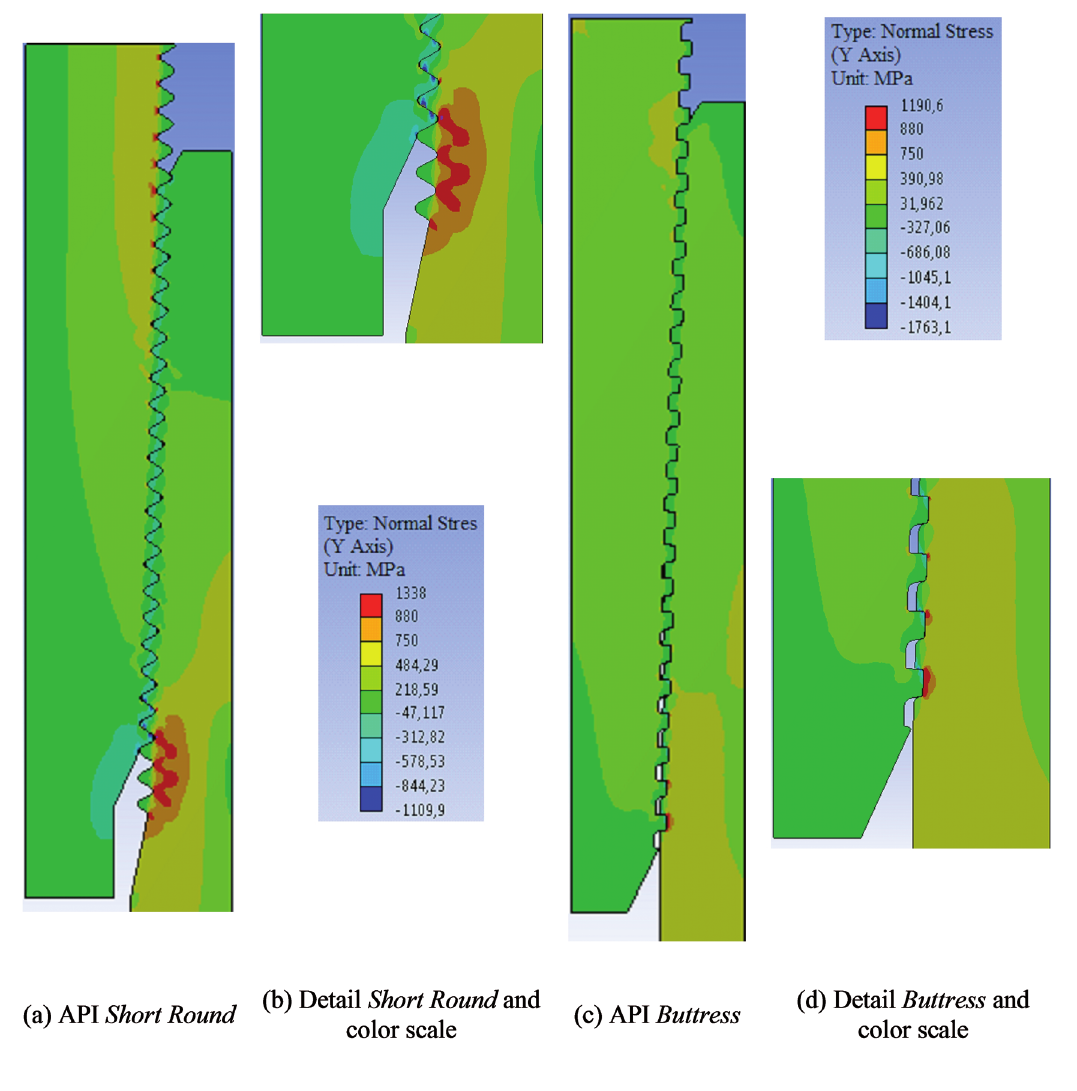
Figure 9: Axial stress distribution on the API connections as a result of maximum make-up torque and 500MPa tensile. Table 6: Stress concentration in API Short Round and Buttress obtained in different tensile stress.